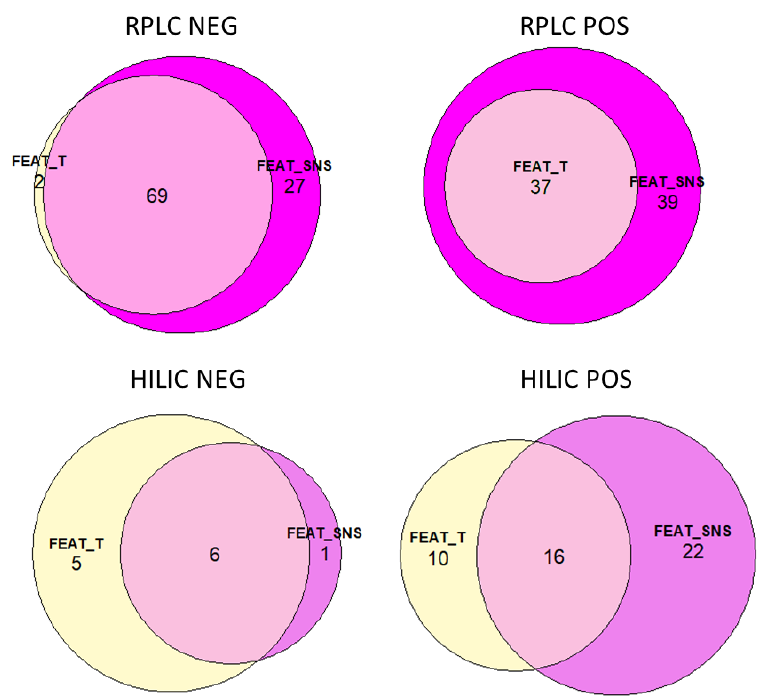
Figure 3. Eulero–Venn graphs for each chromatographic run, showing the differences in the number of statistically different features between the group of smoking subjects and the group of non-smoking subjects, when considering the T-feature list (FEAT-T) or the SNS-feature list (FEAT-SNS).